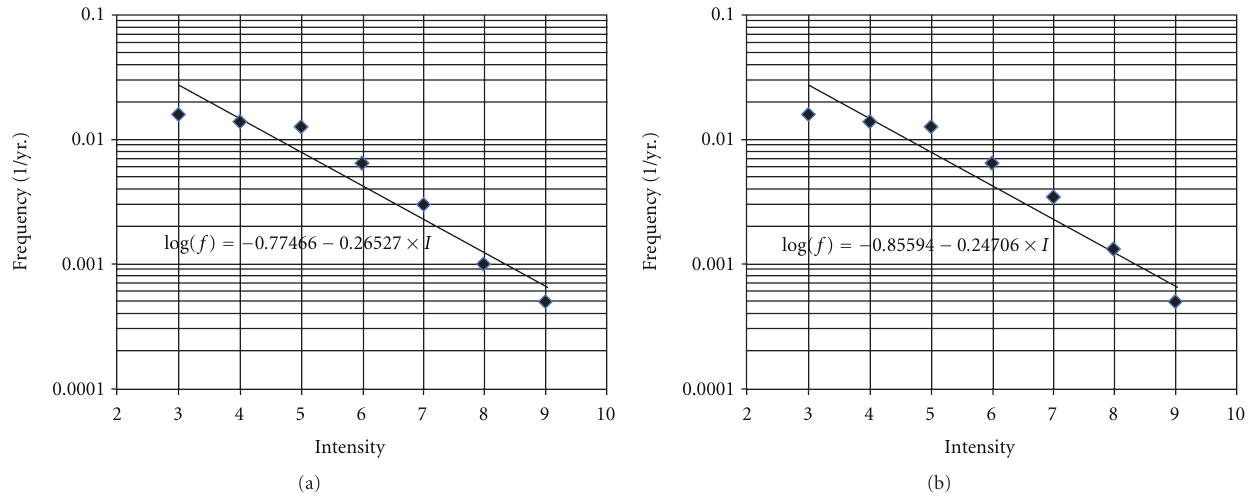
Figure 6: Intensity hazard curves in Tianshui urban area. (a) At Site B1 and (b) at Site B2 in Figure 5.